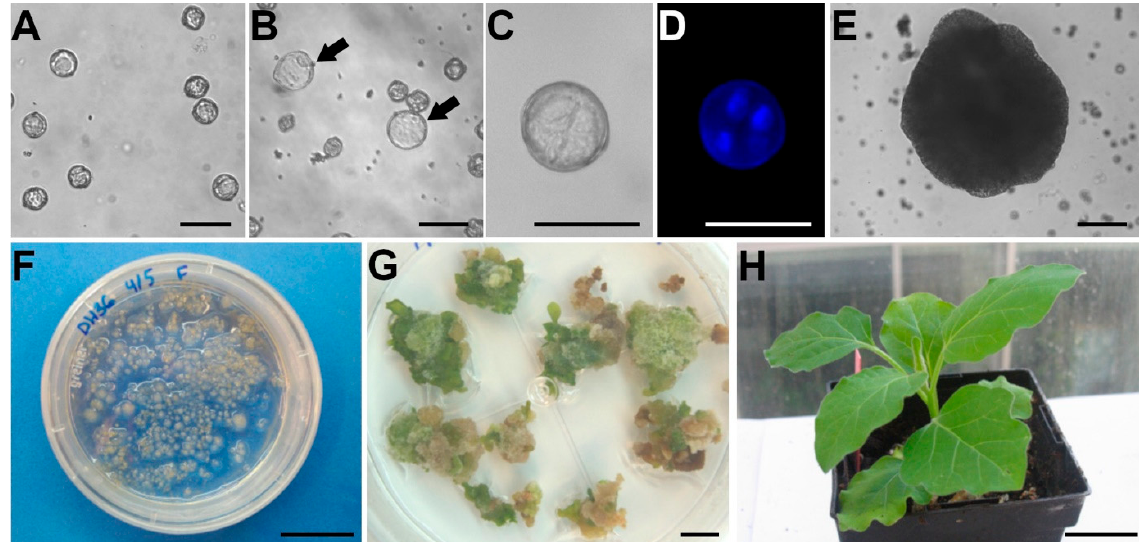
Figure 2. Isolated microspore culture in eggplant. ( A ). Microspores freshly isolated from eggplant anthers and cultured in vitro in liquid medium. ( B ). Cultured microspores after the induction treatment. Most microspores remain arrested, with no evident development, whereas others enlarge (arrows) as a consequence of embryogenesis induction. ( C , D ). Multicellular microspore-derived structure as seen under phase contrast ( C ) and DAPI staining for visualization of the nuclei ( D ). ( E ). Callus-like structure formed from a microspore-derived embryo in vitro culture. ( F ). Culture dish with microspore- derived calli. ( G ). Regenerating calli where multiple green, organogenic nodules are seen on their surface. ( H ). Acclimatized eggplant DH plant obtained through microspore culture. Bars: A–E: 50 µm; F, G: 1 cm; H: 5 cm.